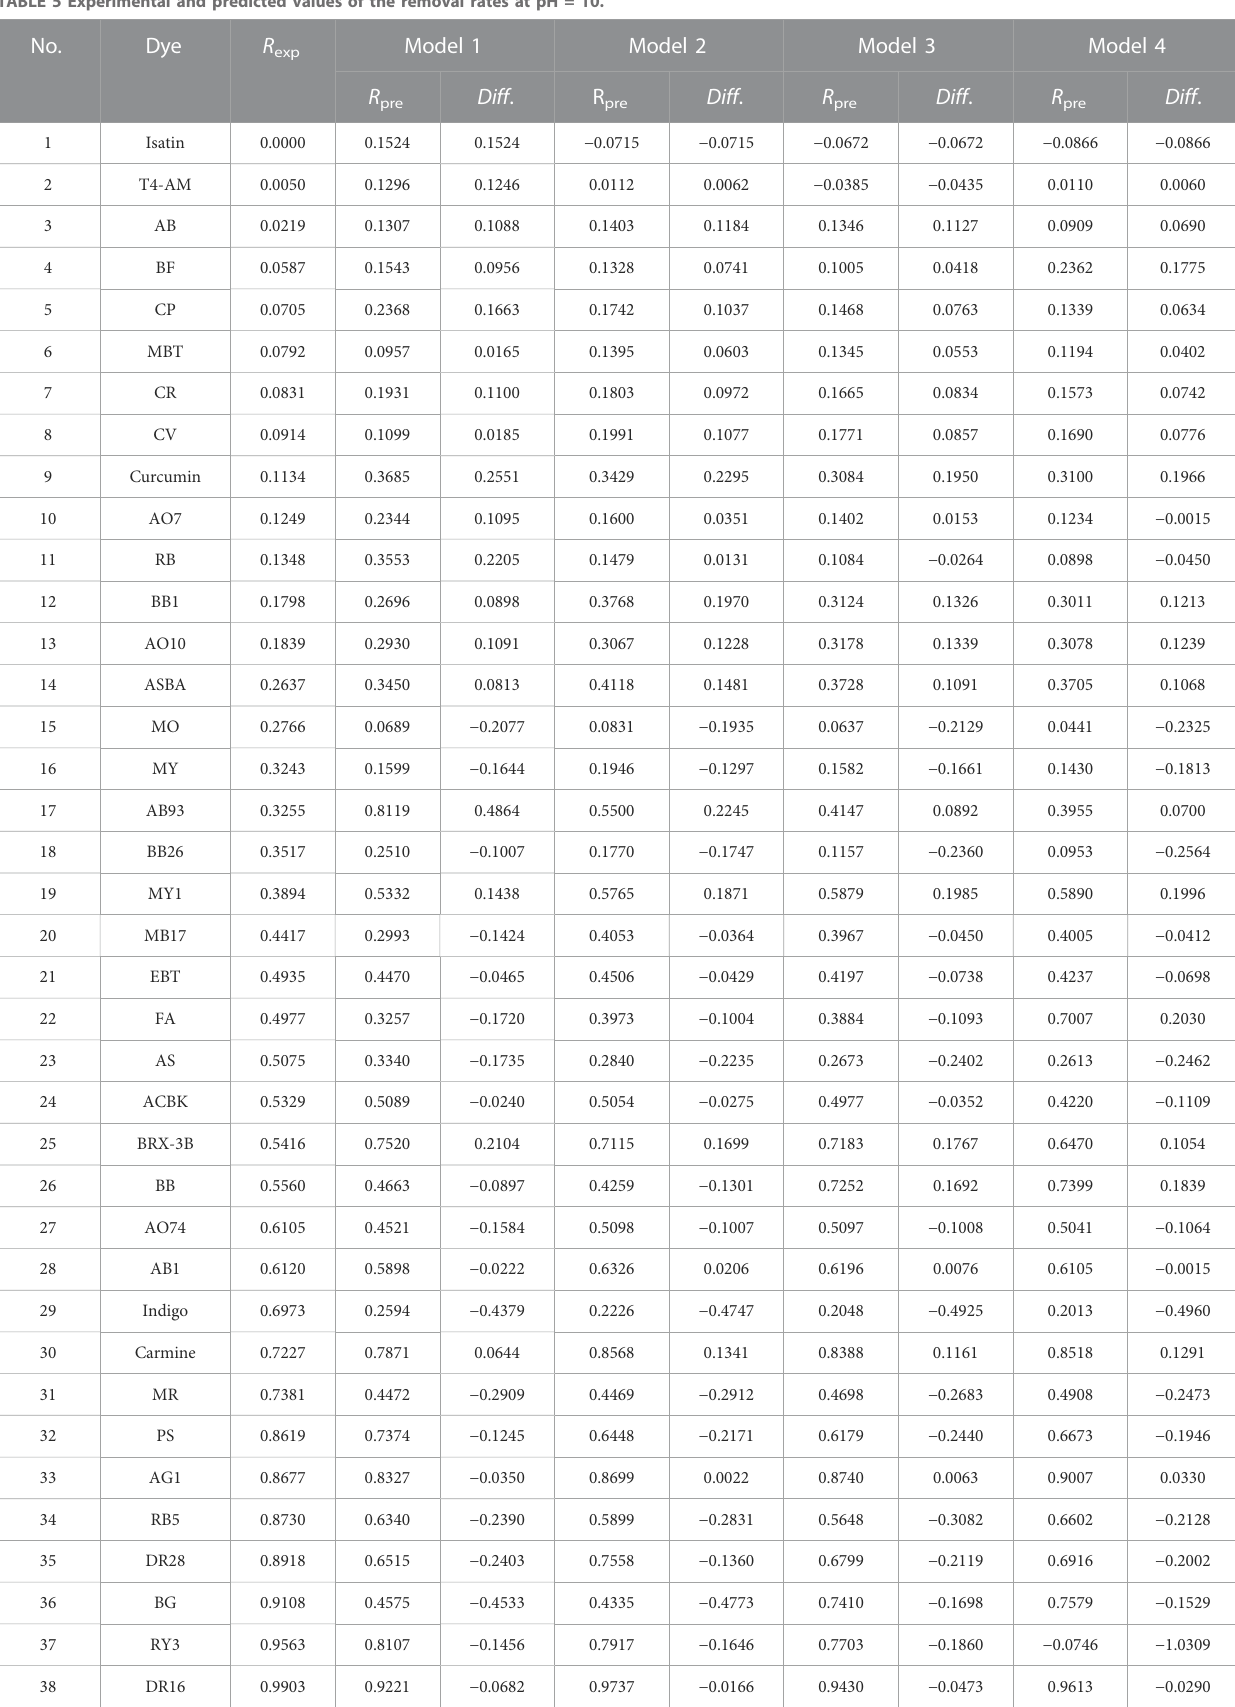
TABLE 5 Experimental and predicted values of the removal rates at pH = 10.